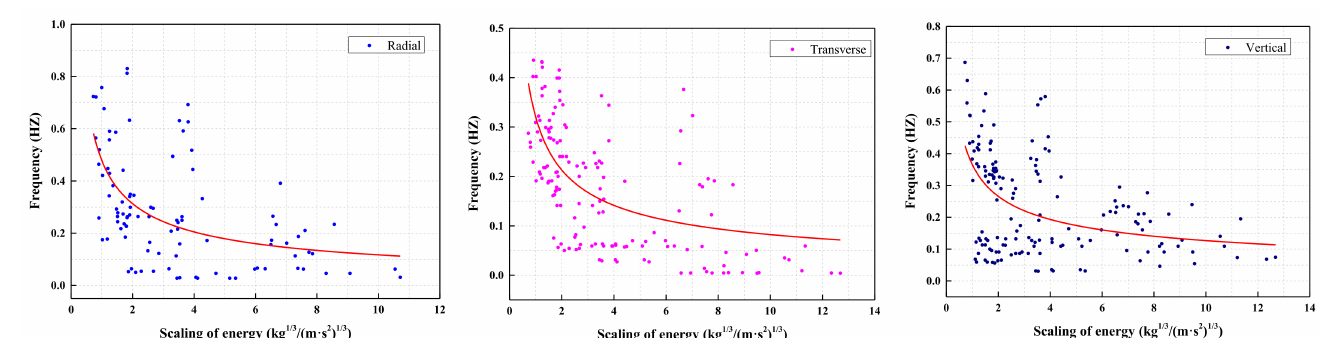
Figure 3. The plot of PPV in different directions.